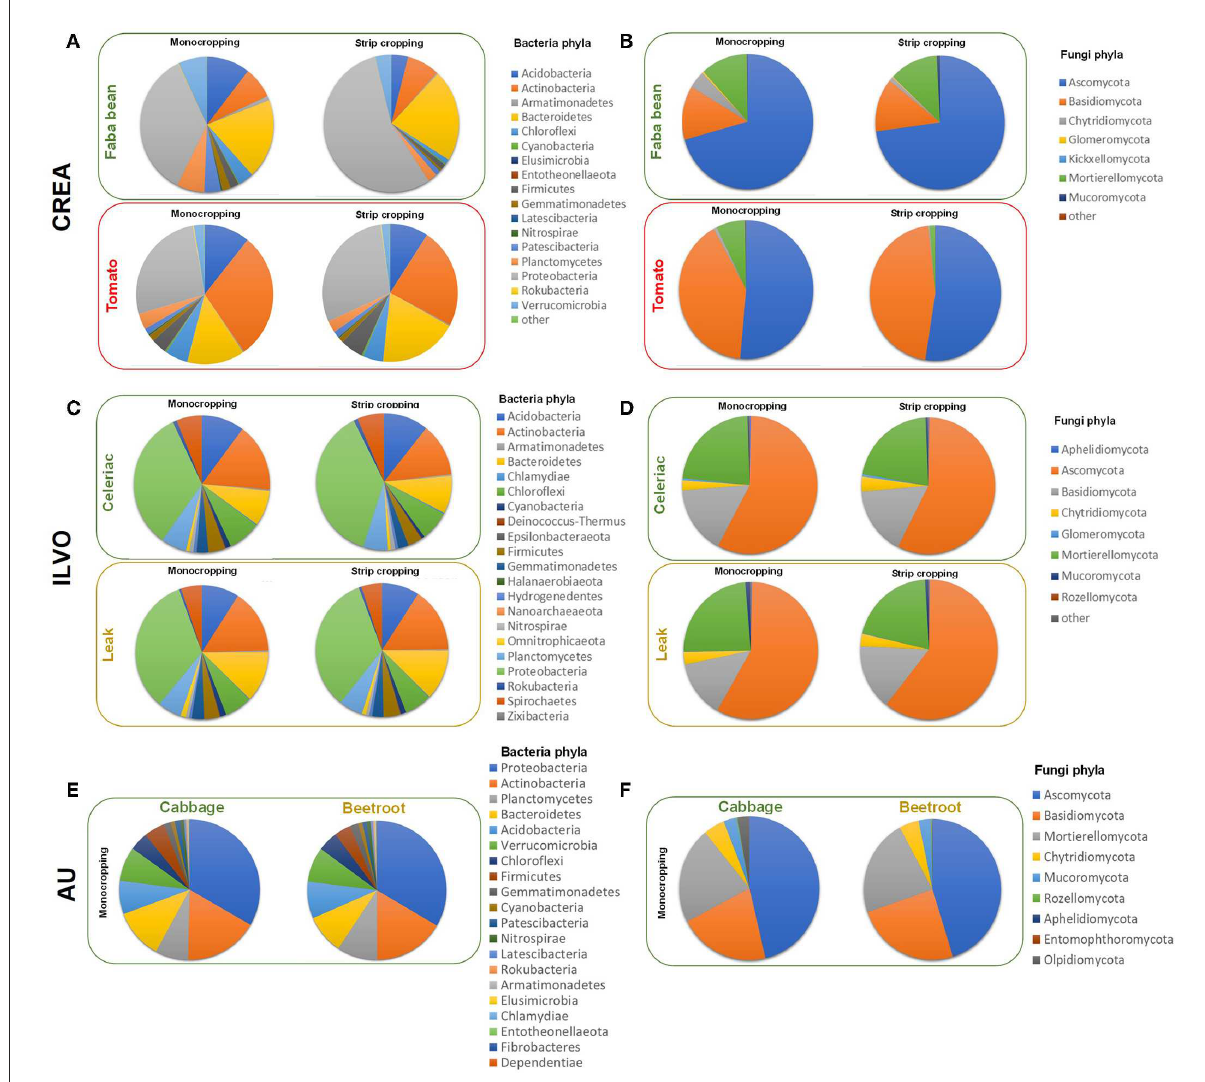
FIGURE6 The relative abundance of bacteria and fungi phyla recorded in CREA [ (A) = bacteria phyla; (B) = fungi phyla], ILVO [ (C) = bacteria phyla; (D) = fungi phyla], and AU [ (E) = bacteria phyla; (F) = fungi phyla] experimental sites were calculated, considering the crop type and the cropping systems (in AU site, only the crop effect is